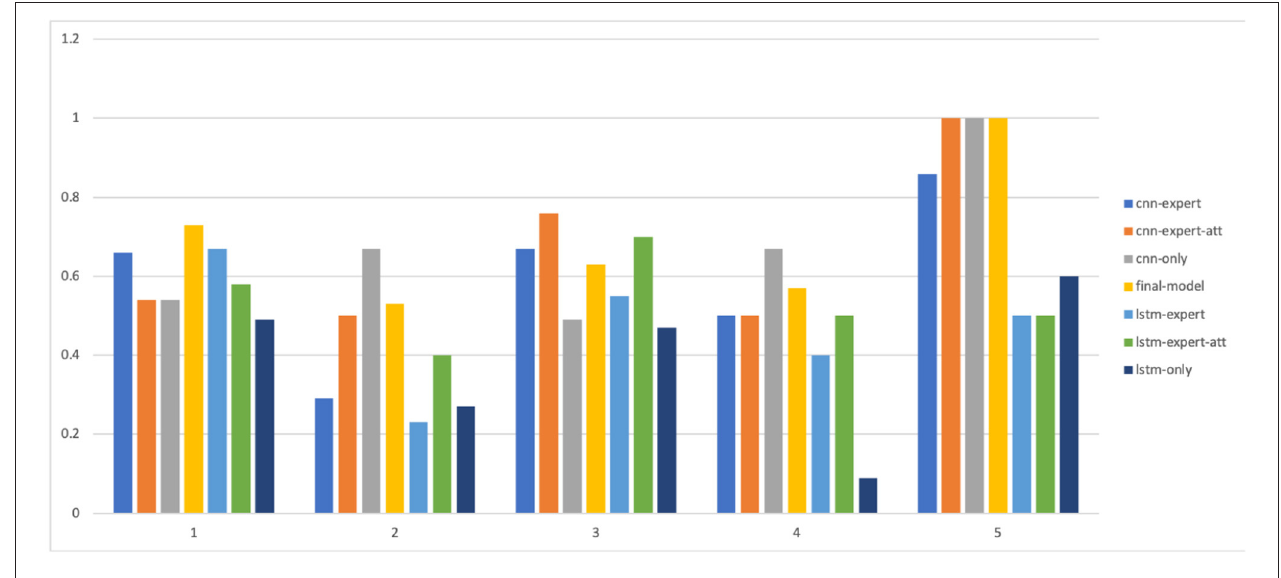
FIGURE 8 | Precision of all the models for each level.